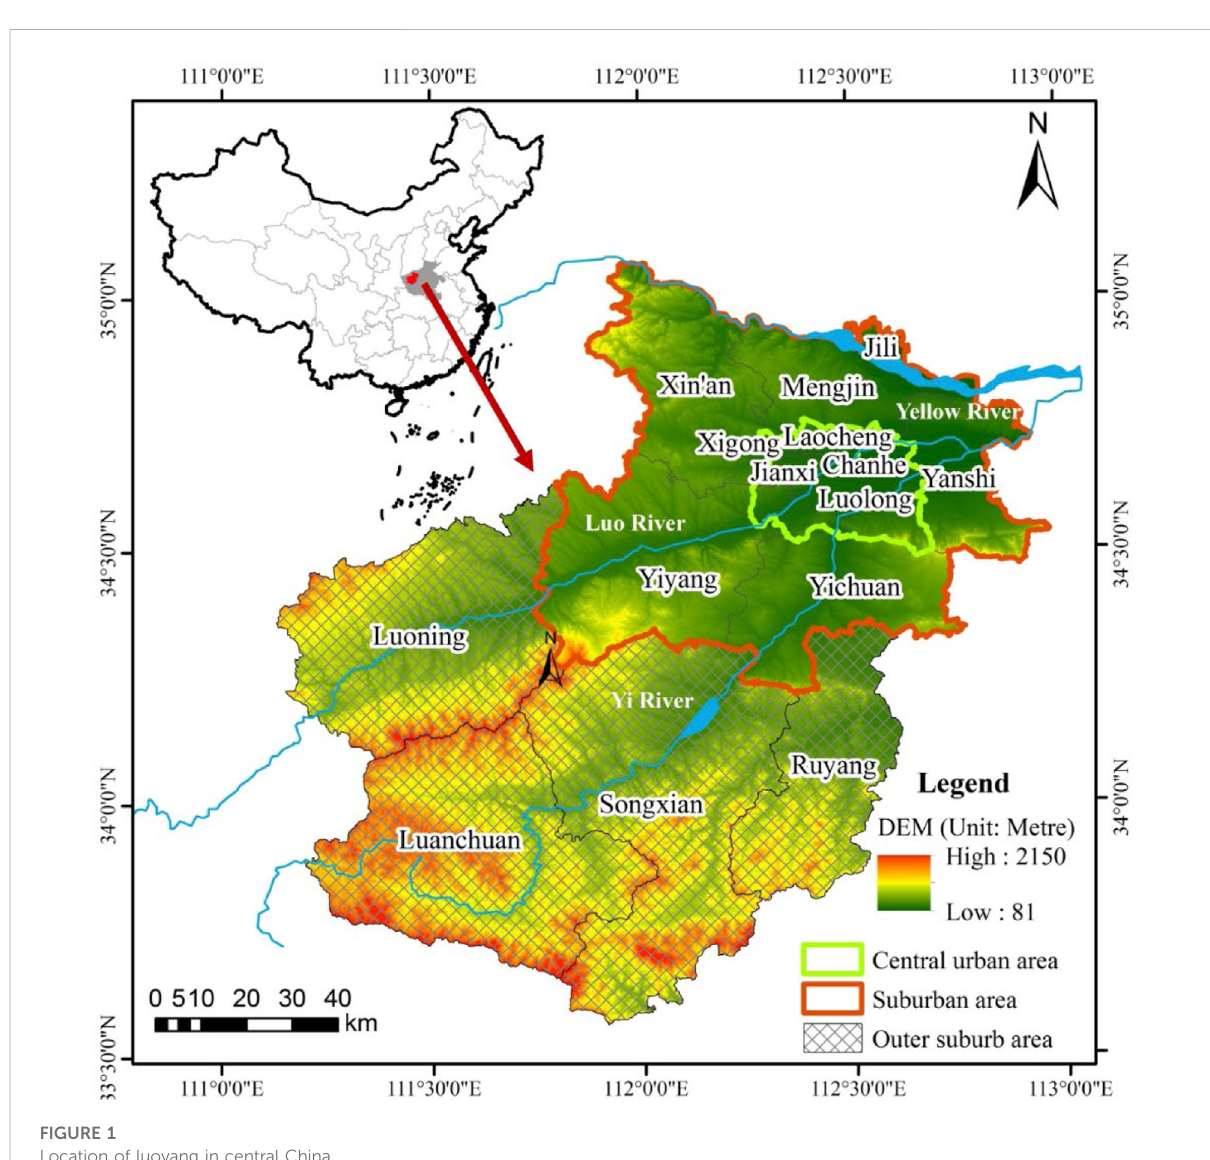
FIGURE 1 Location of luoyang in central